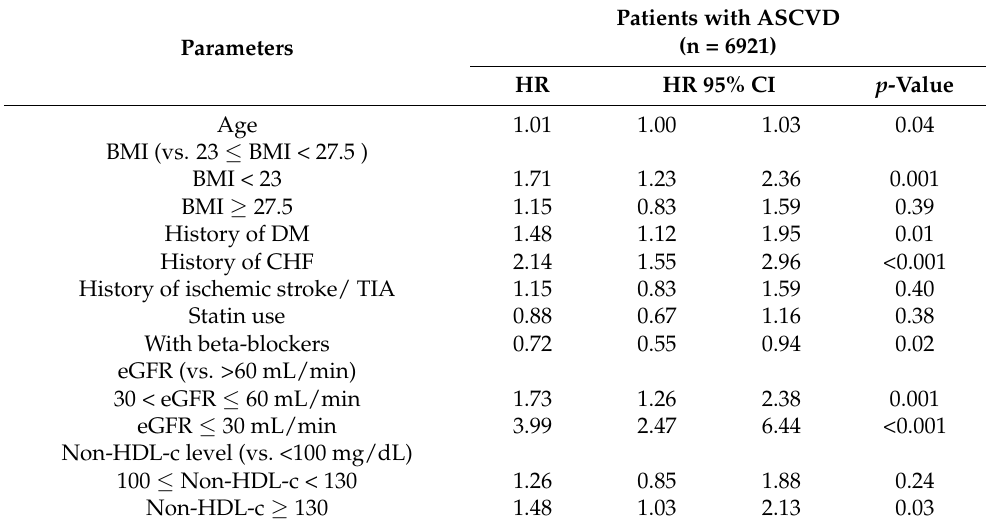
Table 3. Multivariate Cox PH model for predicting MACE among patients with ASCVD.